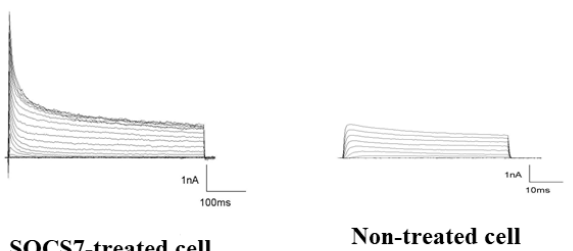
Figure 6. Electrophysiological properties of peptide-treated cells. Voltage-gated inward and outward currents were recorded in the whole-cell path-clamp configuration. Left, a SOCS7-peptide-treated cell elicited both large outward K + currents and fast inward N + Current. Right, a non-treated cell elicited small outward K + currents and minute fast Na+ currents.